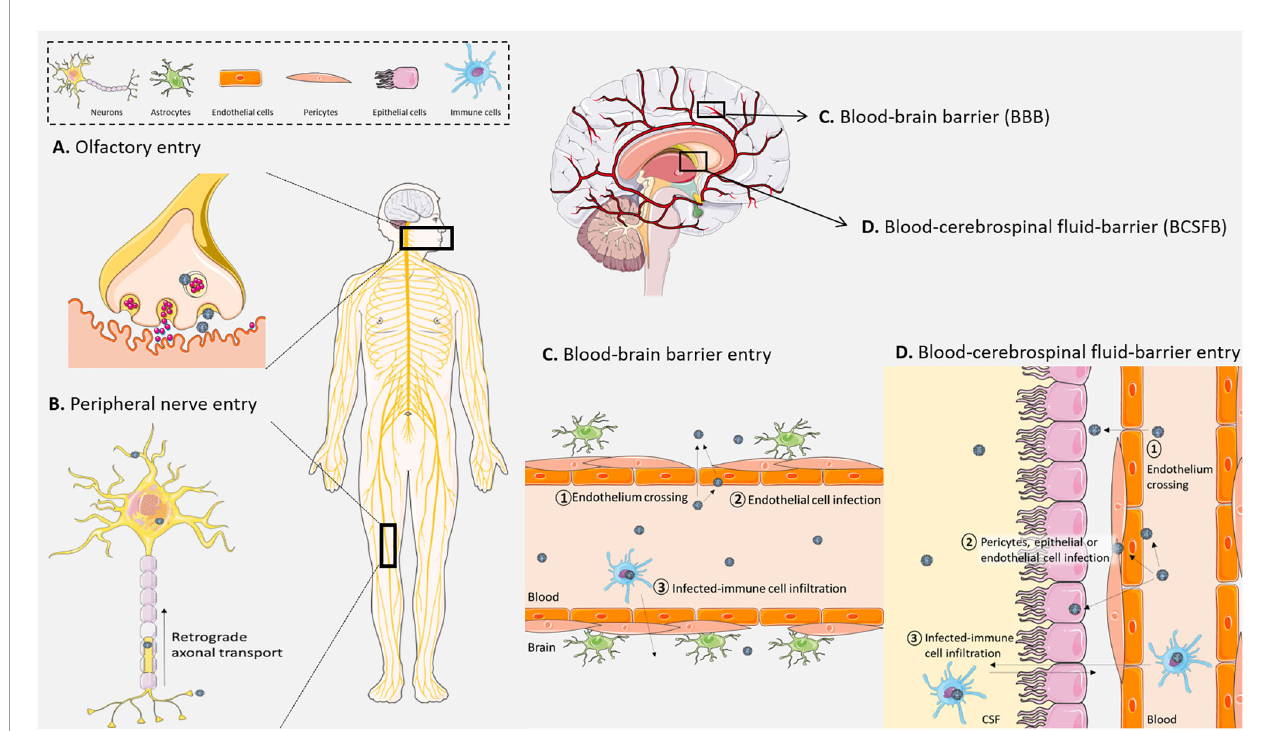
FIGURE 1 | Different viral modes of access to the central nervous system (CNS). (A) Viruses can be up taken by nerve terminals at the olfactory bulb to gain access to the CNS. (B) They also can infect peripheral neurons and use long-range retrograde axonal transport. (C) At the blood – brain barrier (BBB), (1) viruses can directly cross the endothelium (by paracellular or transcellular ways), (2) they can infect and replicate in brain endothelial cells and be released in the CNS, (3) and fi nally they can pass through the BBB by infecting immune cells that cross the endothelium through the “ Trojan horse ” mechanism. (D) At the blood – cerebrospinal fl uid barrier, (1) viruses can directly cross the endothelium, (2) they can also infect, replicate, and be released from endothelial cells, pericytes, or epithelial cells of the choroid plexus, (3) and fi nally infected immune cells can also cross this barrier and deliver viruses in the CNS. Created with SMART Servier Medical